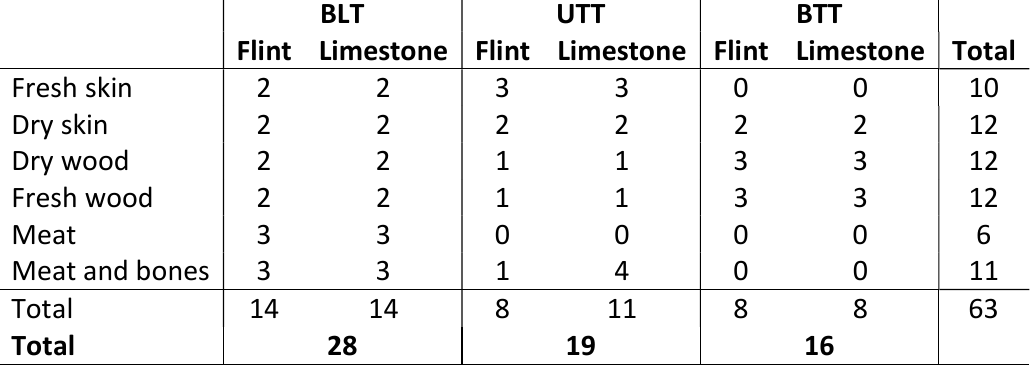
Table 2. Summary of the counts, actions and worked material of the experimental pieces during the second step of the